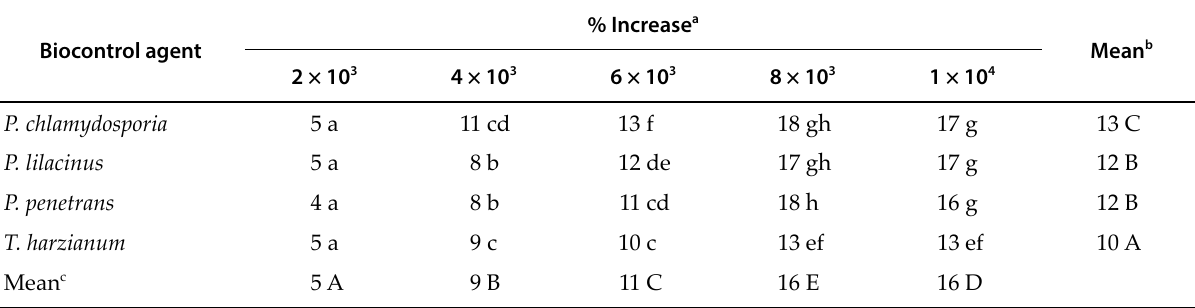
Table 4. Mean proportional increases in shoot lengths of okra plants after treatments with different nematode biocontrol agents applied at different propagule